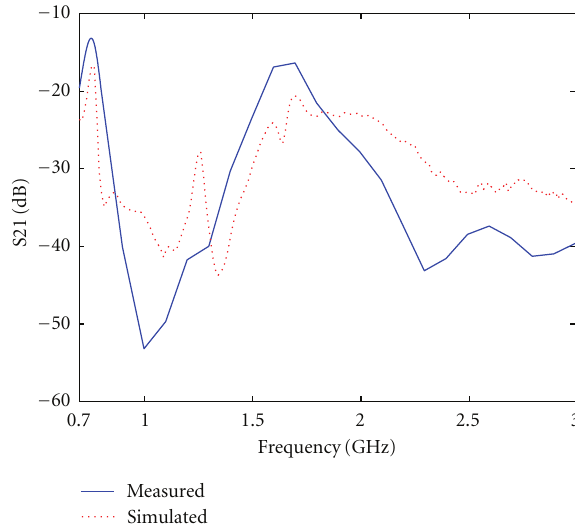
Figure 4: 3D radiation patterns of the two antenna elements.